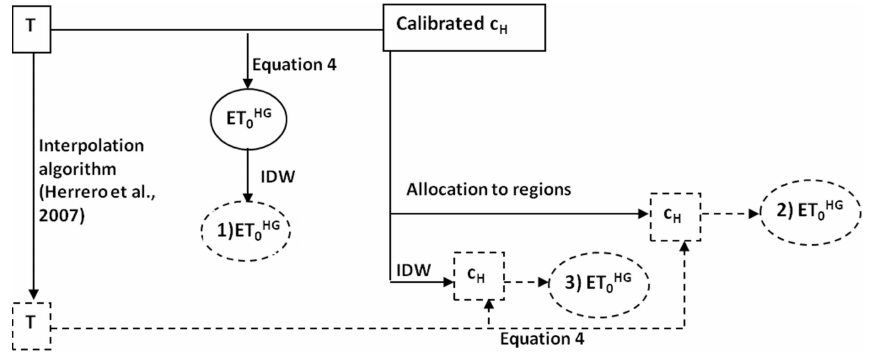
Fig. 2. Methodologies for the spatial interpolation of Hargreaves ET 0 : (1) C-I type and both (2) and (3) I-C types. Solid lines represent values at point scale (weather station) whilst dashed lines represent distributed values at cell